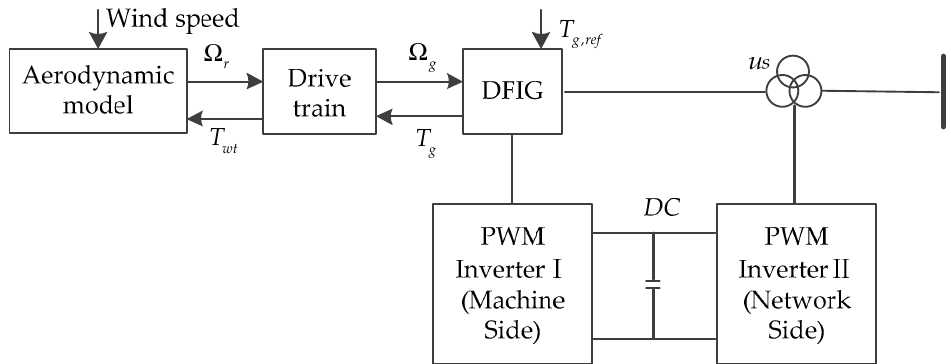
Figure 1. Overall block diagram of the wind energy conversion system (WECS) with a doubly fed induction generators (DFIG).